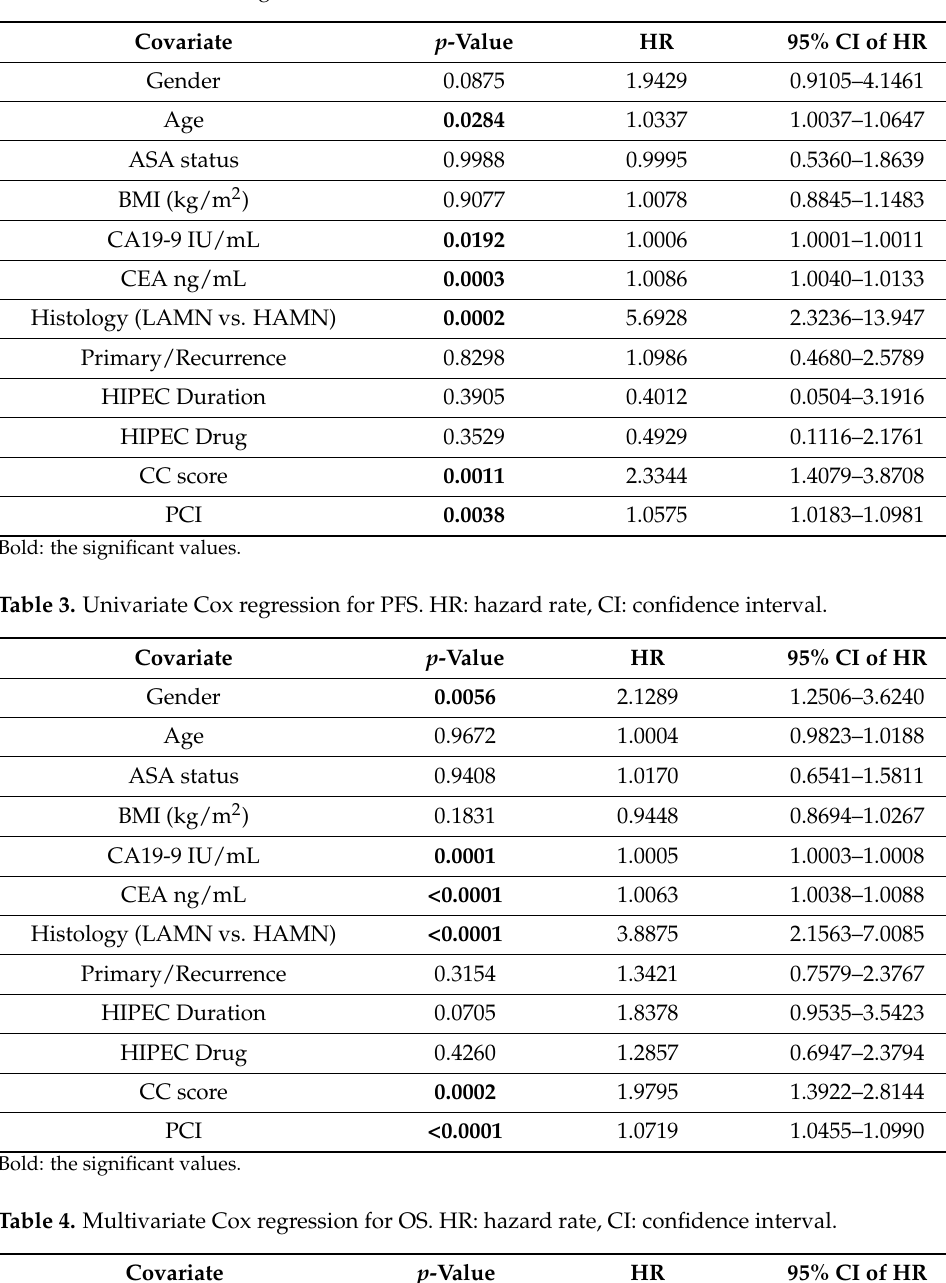
Table 2. Univariate Cox regression for OS. HR: hazard rate, CI: confidence interval.